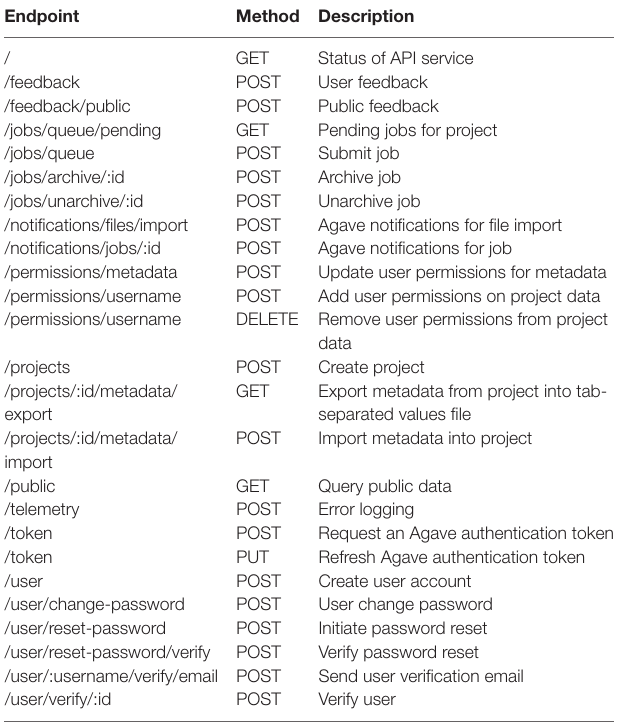
TABle 1 | VDJServer release 1.0